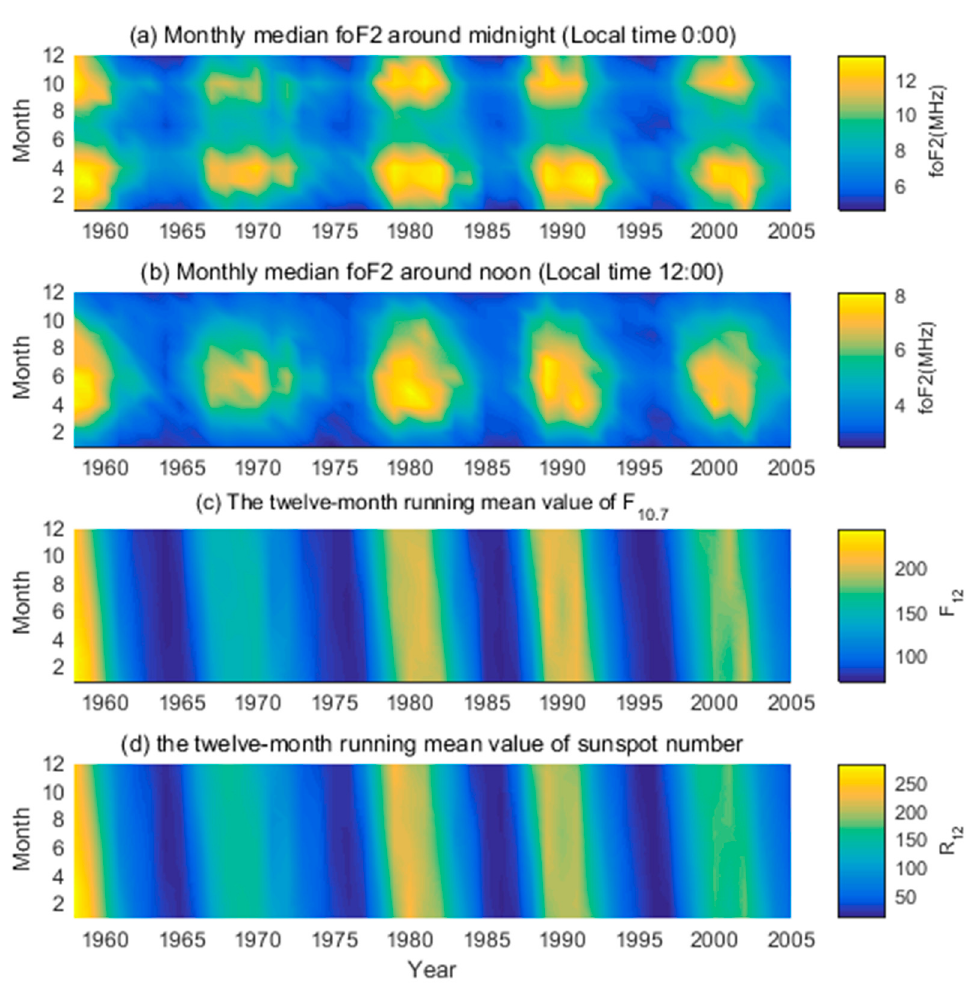
Figure 4. Behavior of the monthly median values of critical frequency and the twelve-month running mean value of solar indices at 4:00 UT during the years from 1958 to 2005 over Kokubunji, Japan. ( a ) Month median f o F 2 (MHz) around midnight (Local time is 00:00 clock); ( b ) month median f o F 2 (MHz) around noon (Local time is 12:00 clock); ( c ) the twelve-month running mean value of sunspot number ( F 12 ); ( d ) the twelve-month running mean value of sunspot number ( R 12 ).